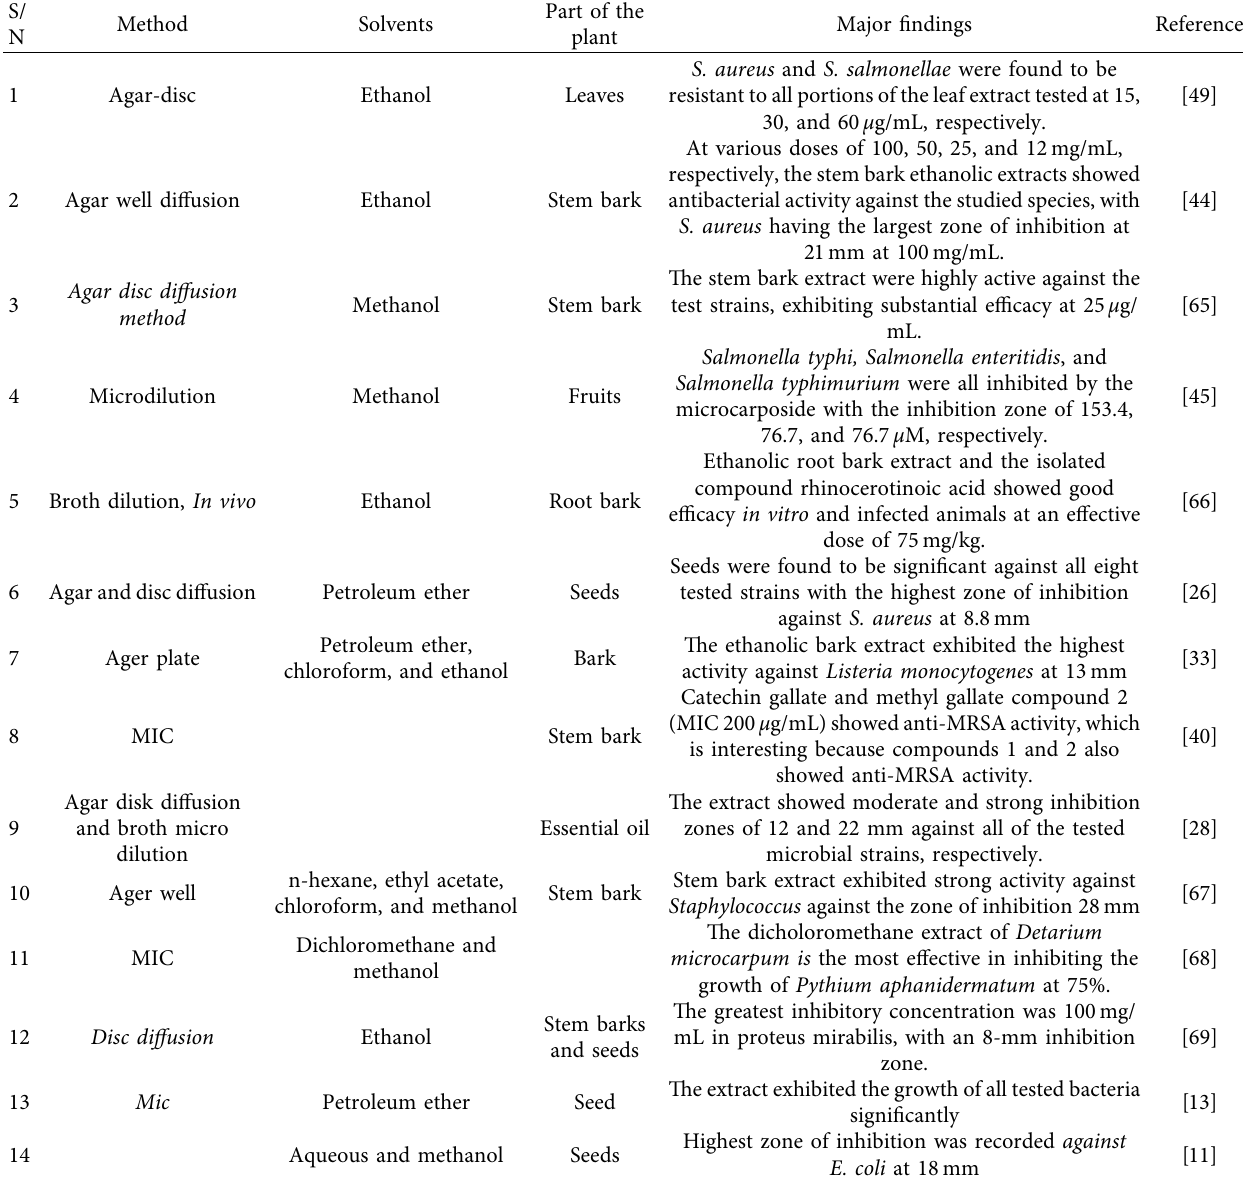
Table 4: Antibacterial activity of D. microcarpum